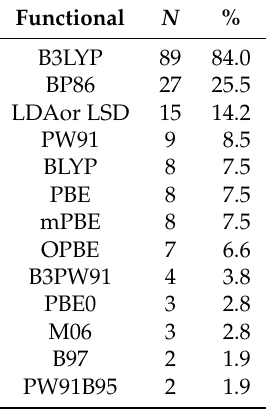
Table 1. Density functionals most often mentioned in the bibliographic sources and the percentage within the sources referring to Density Functional Theory (DFT)